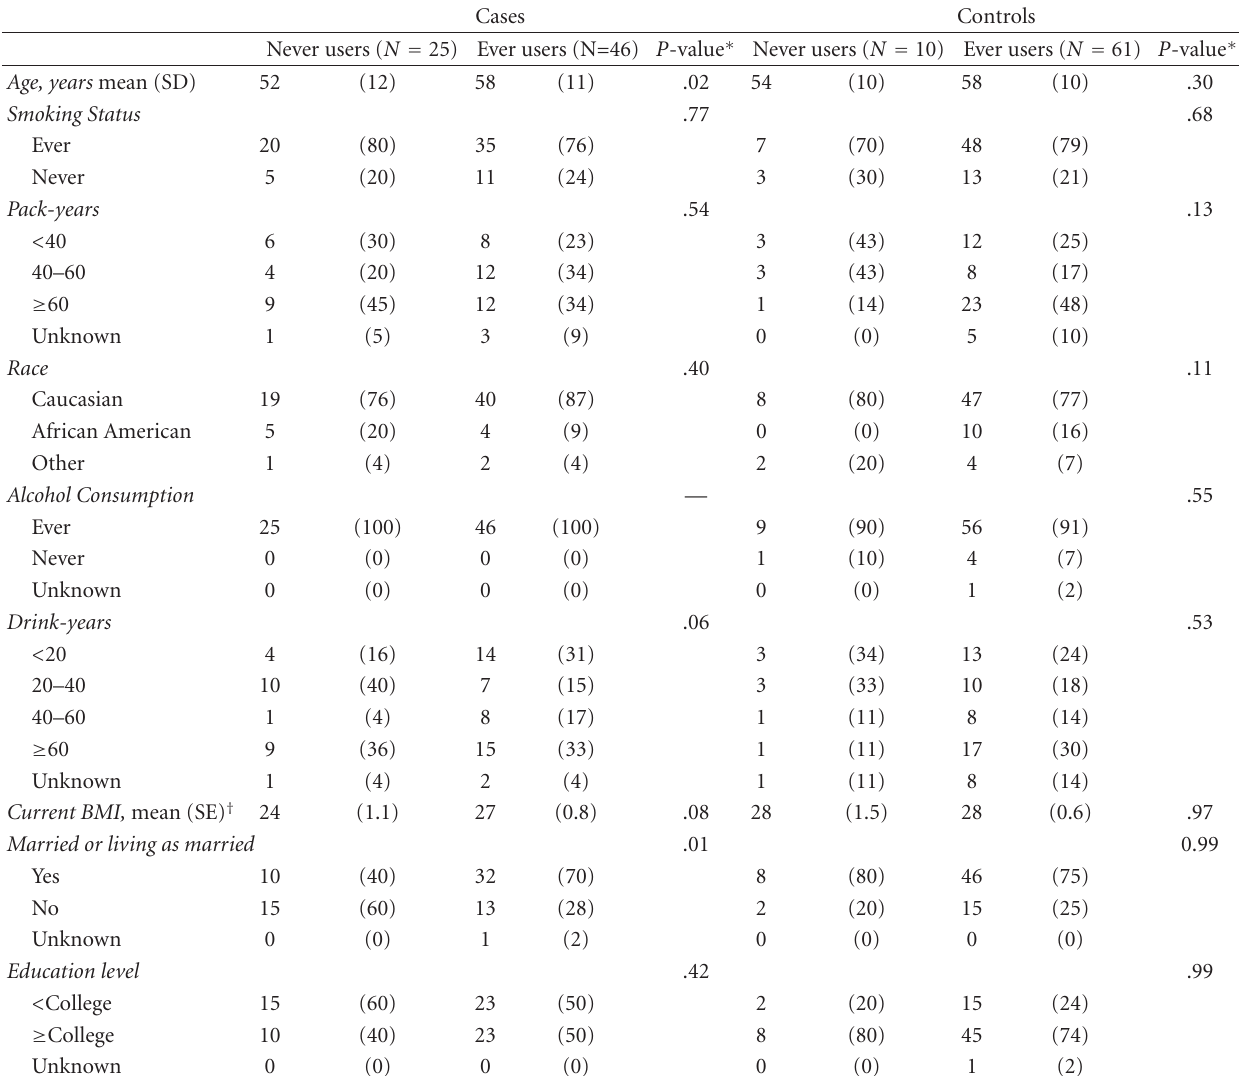
chi-square tests for all other characteristics. Missing values were excluded from the P -value computation. † BMI comparisons were age adjusted. Means are shown for a 56-year-old